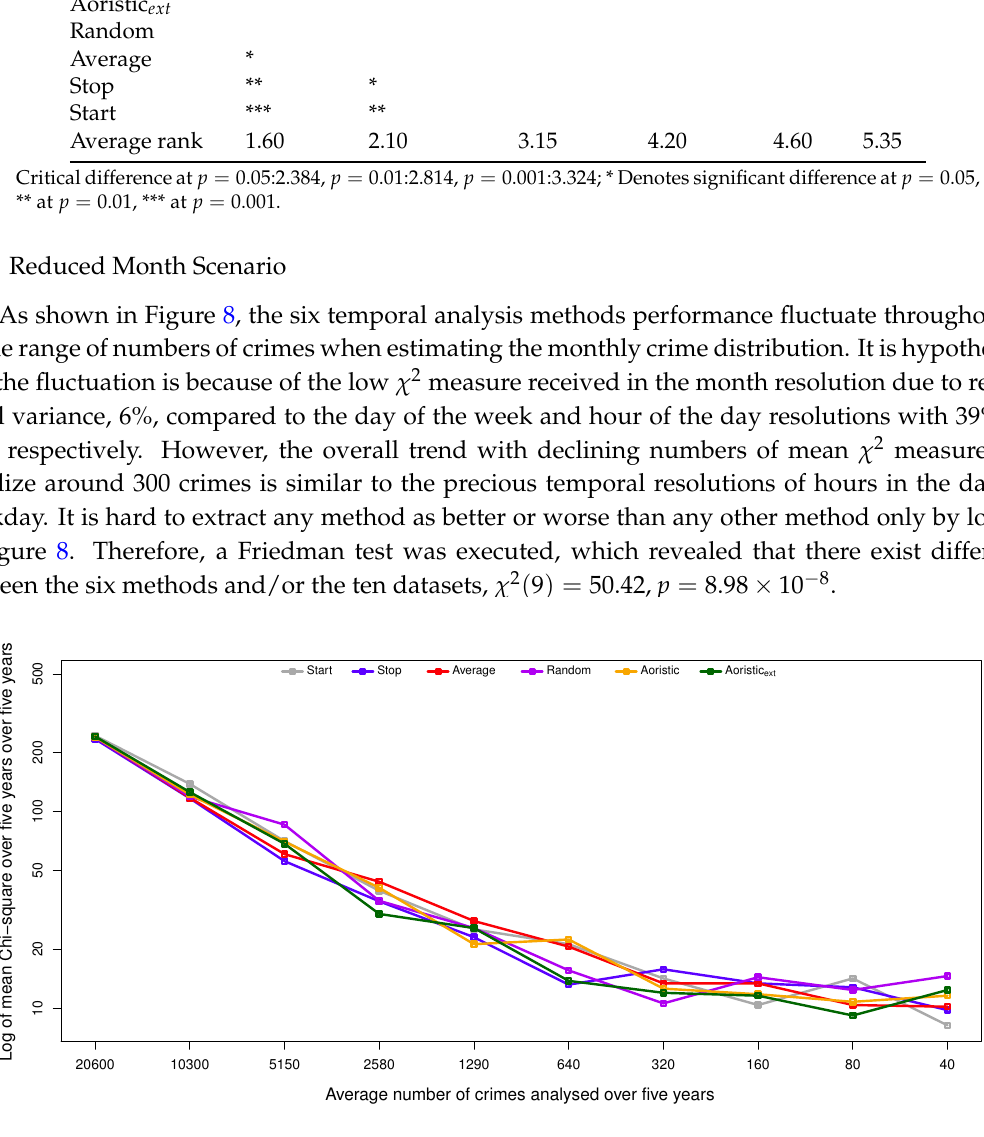
Figure 8. Development of each analysis method with regards to Pearson’s χ 2 measure of the month distributions as crimes are repeatedly reduced by 50%. The plot is based on all Swedish burglaries between 2010 and 2014 (N =